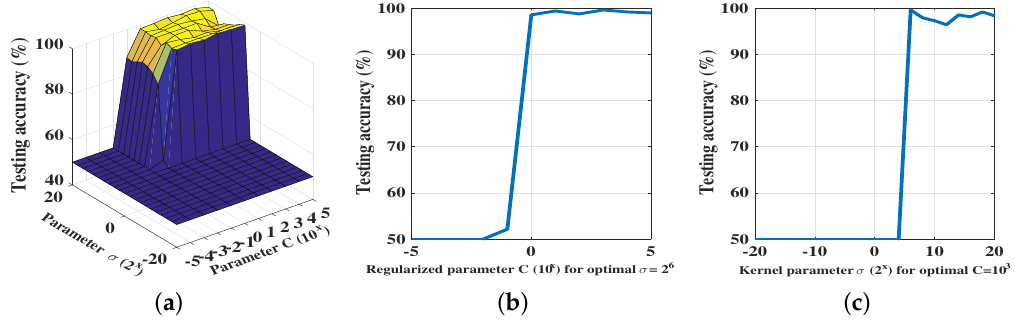
Figure 8. ( a ) Performance of the KRR algorithm across the search space; ( b ) Performance of KRR algorithm for the optimal σ value; ( c ) Performance of KRR algorithm for the optimal C value.